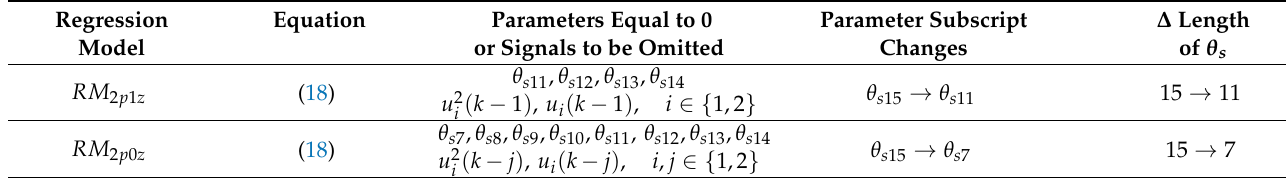
Table 1. Model configurations and corresponding